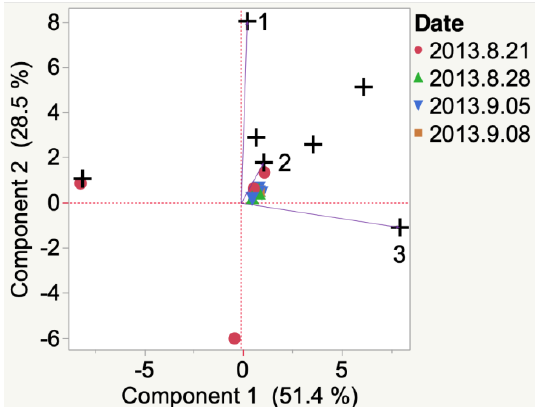
Figure 6. Evolution of VOCs emitted from single berry from veraison to harvest of 2013 Marquette grapes grown in South Dakota. Key to most representative volatiles from HCA, shown as vectors from the origin and read clockwise: 1 = Ethyl octanoate, 2 = 2-Ethyl-1-hexanol, 3 = 1,4-Butanolide. St.